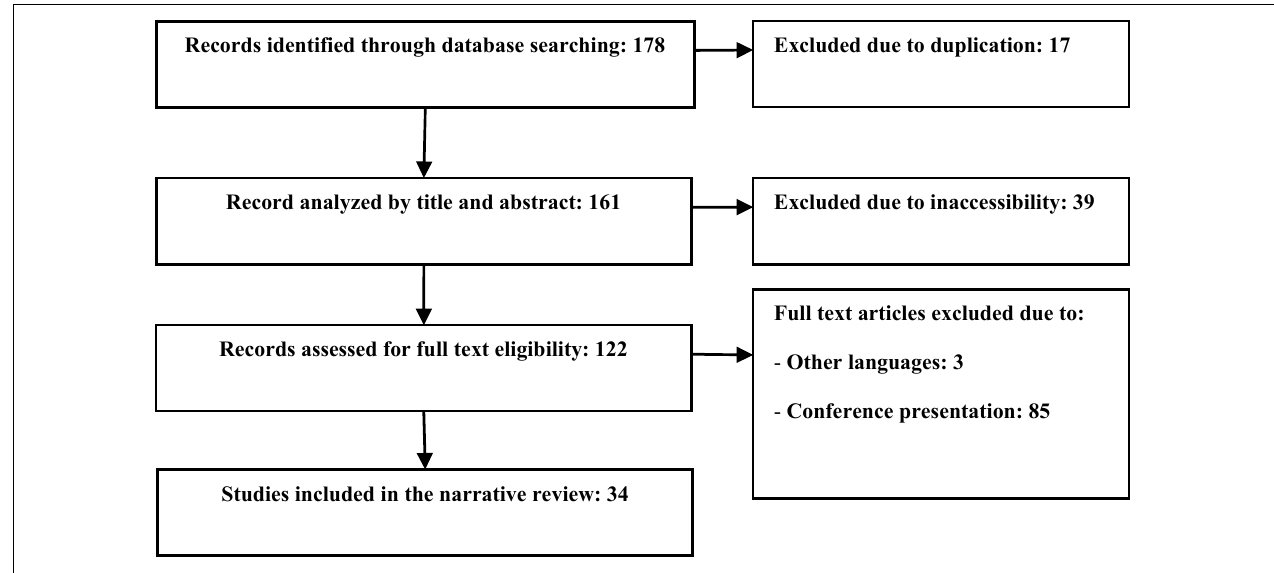
FIGURE 1 | Flow diagram on Blended Learning research in higher